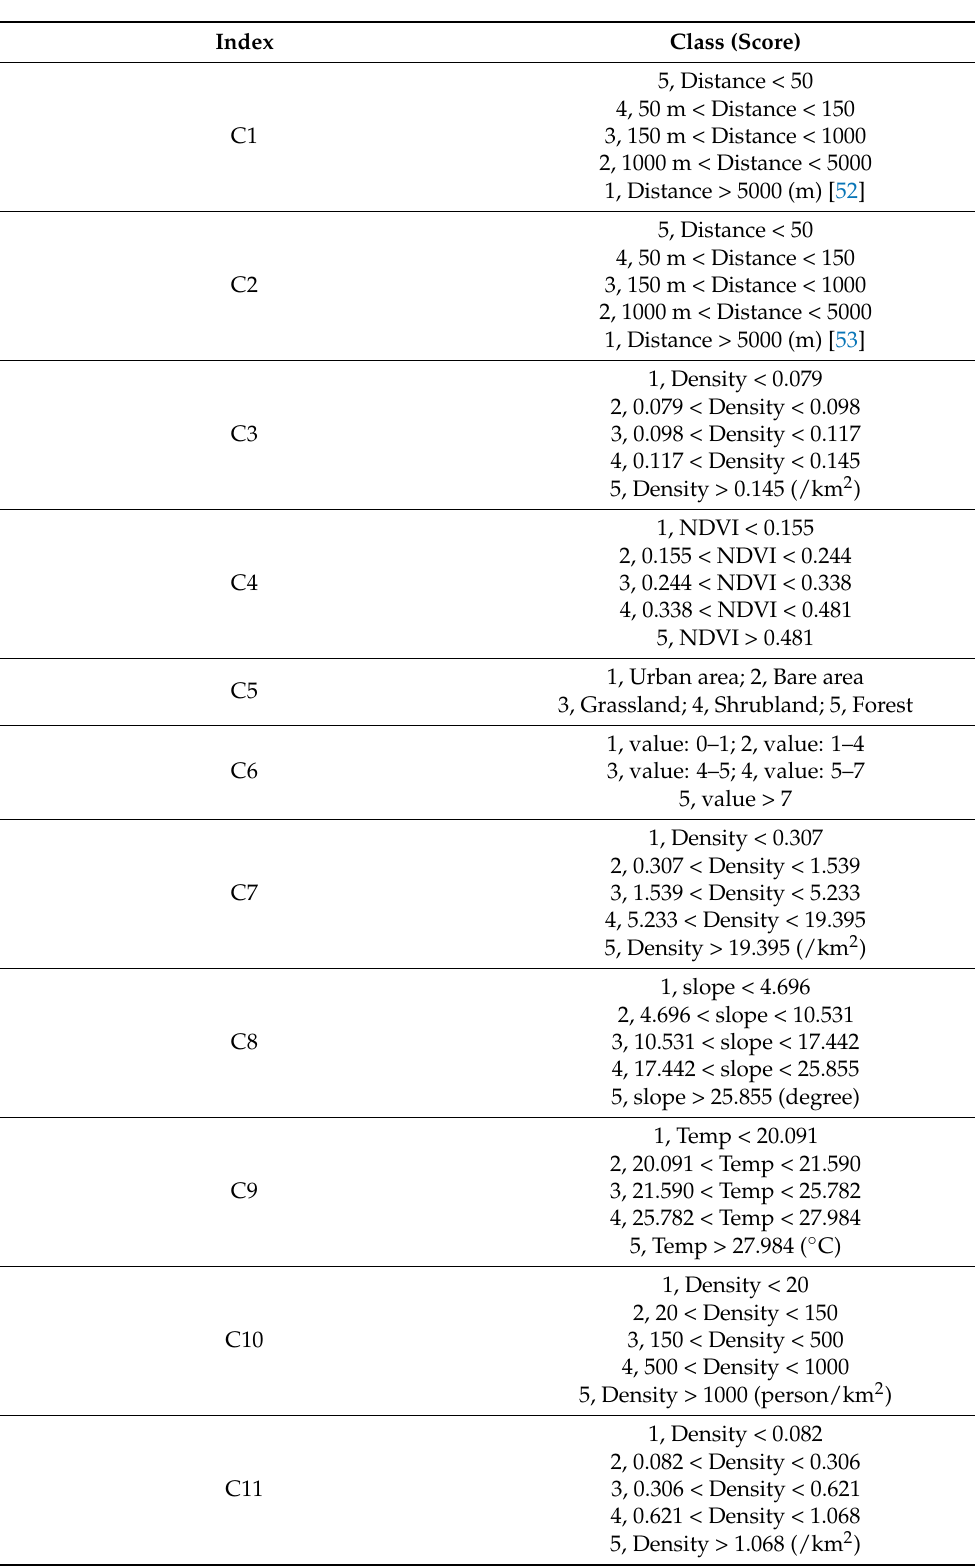
Table 3. Rule of reclassification of